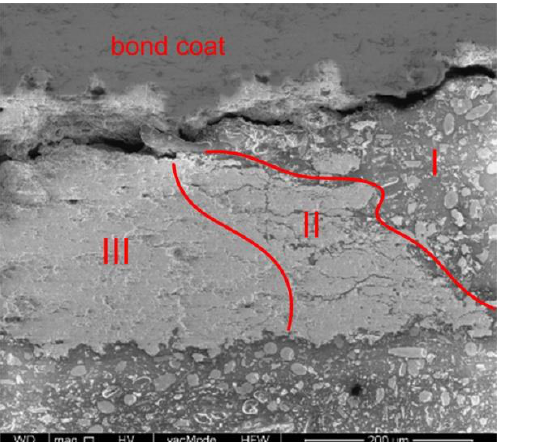
Figure 3. Damage areas of the top-coat.